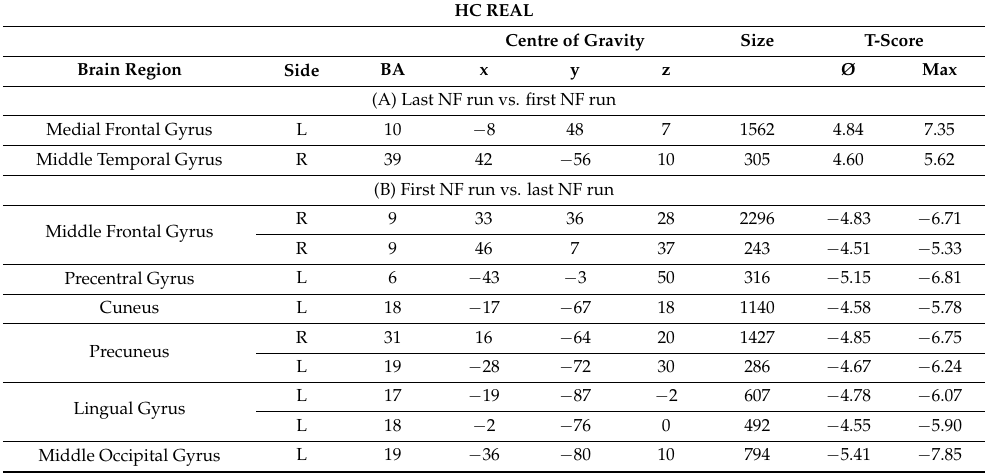
Table 6. Comparison of hemodynamic responses between the first and the last NF run, HC REAL and MDD REAL (negative emotion-associated pictures minus neutral pictures; clusters of >30 voxels, q (FDR) < 0.001, T-score: 8 to − 8).